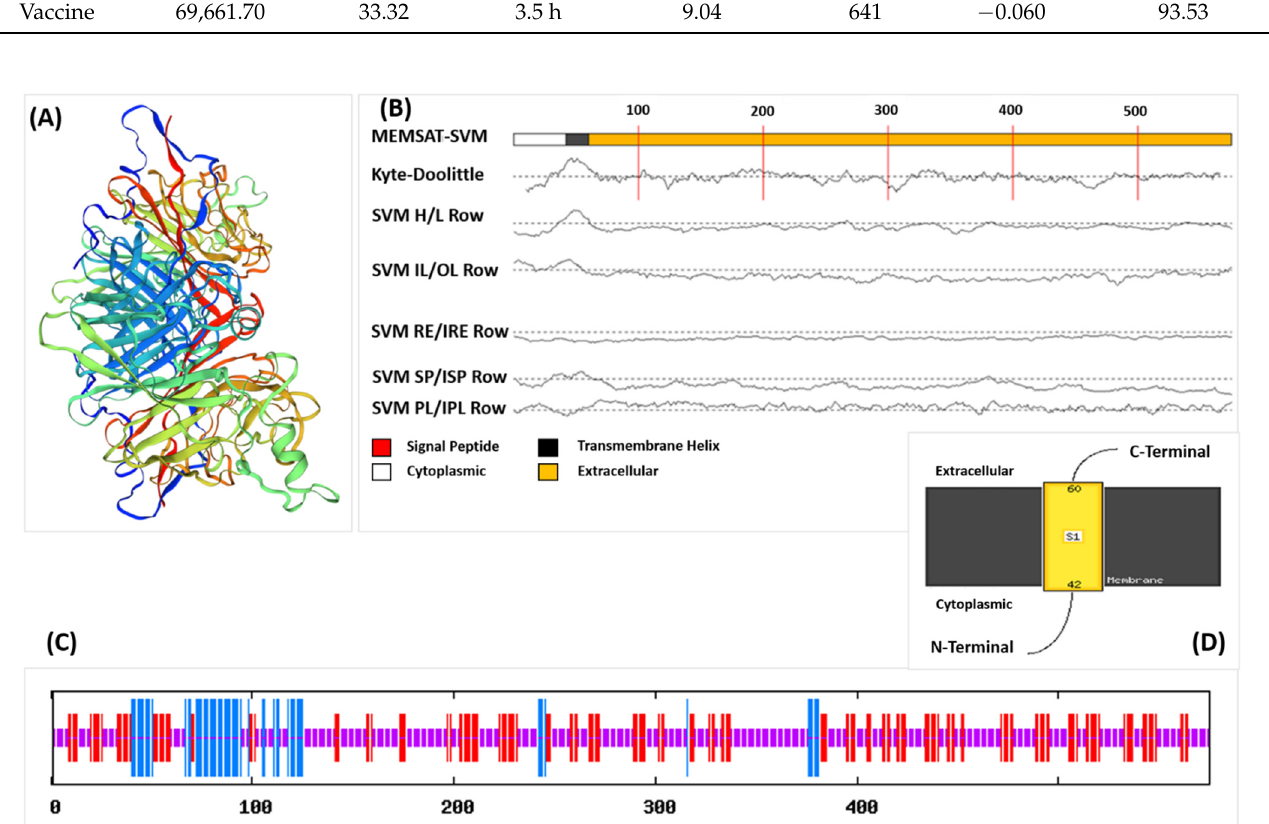
Figure 1. ( A ) Three-dimensional (3D) structure of the HN protein obtained from PDB, ( B ) MEMSAT predicted by PsiPred showing the Topology of the HN protein, ( C ) Secondary structure of HN protein predicted by SOPMA showing different components in different colors, ( D ) MEMSAT showing extracellular part of HN protein.